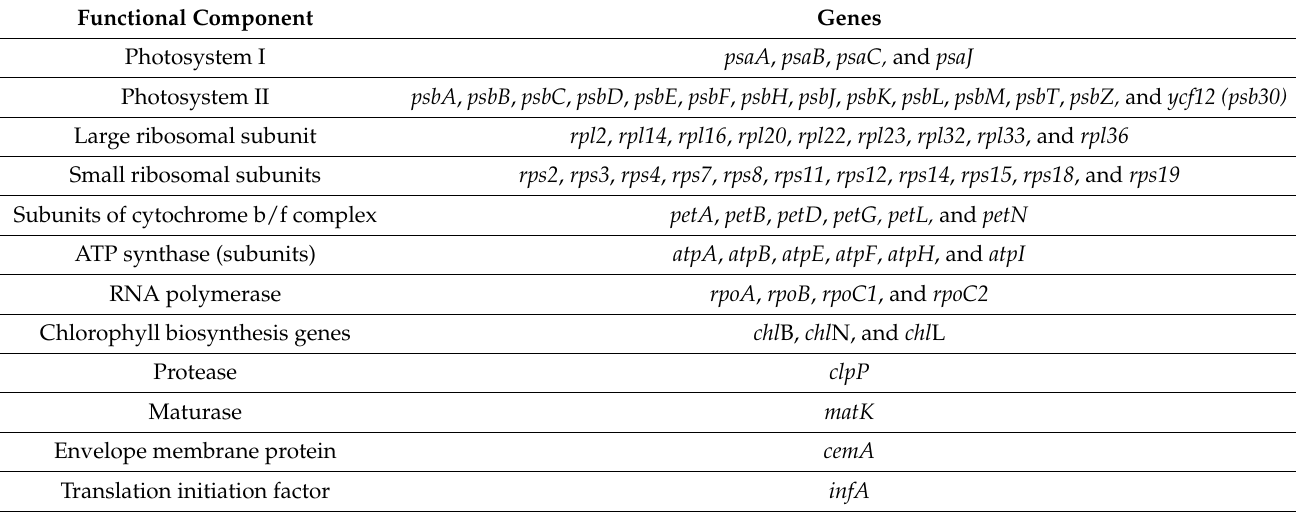
Table 2. Gene contents of the P. rubens chloroplast genome based on genome